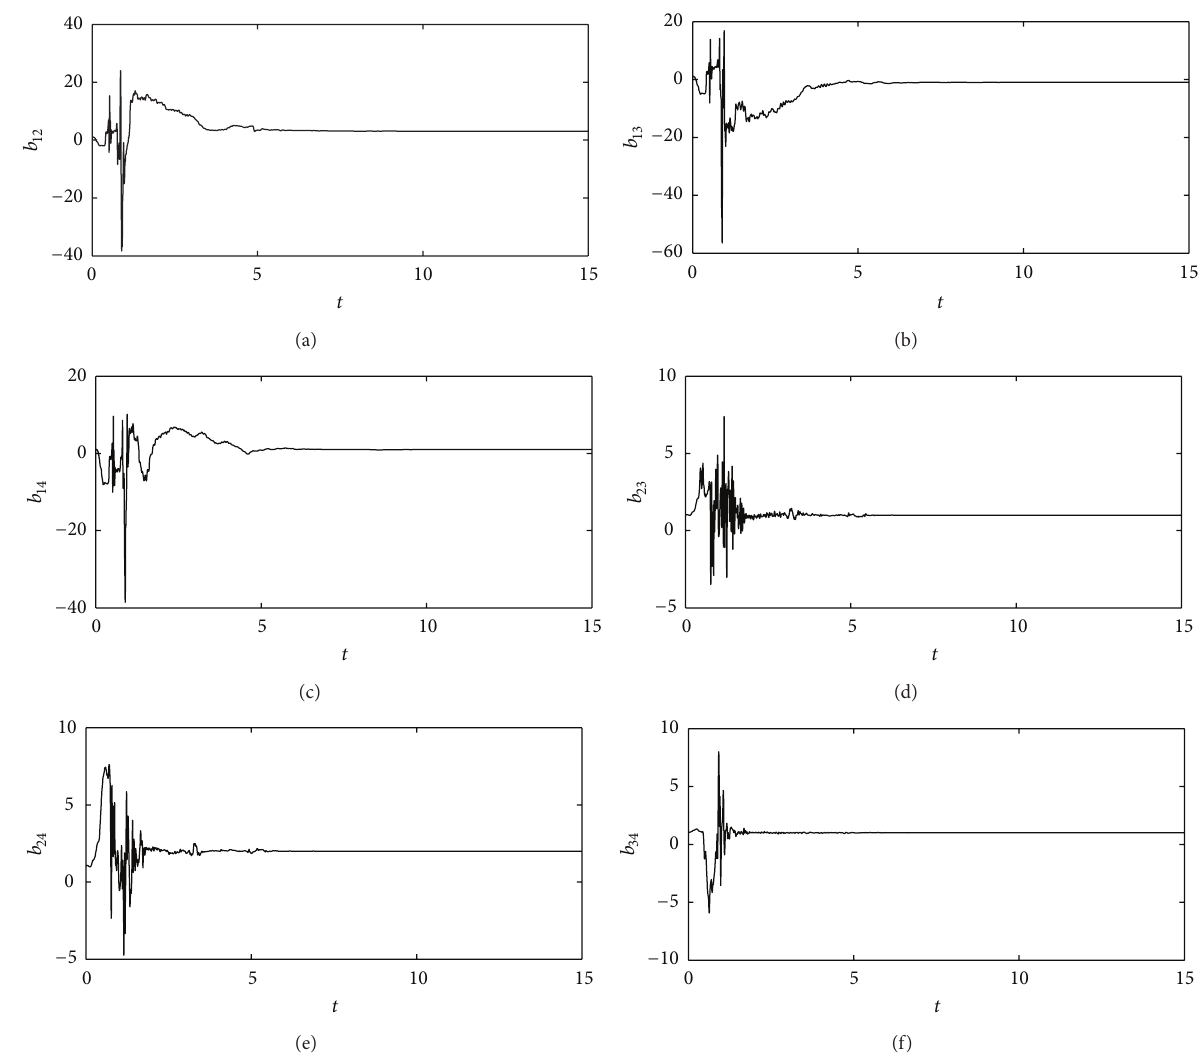
Figure 3: Identification of network structure (some elements of matrix